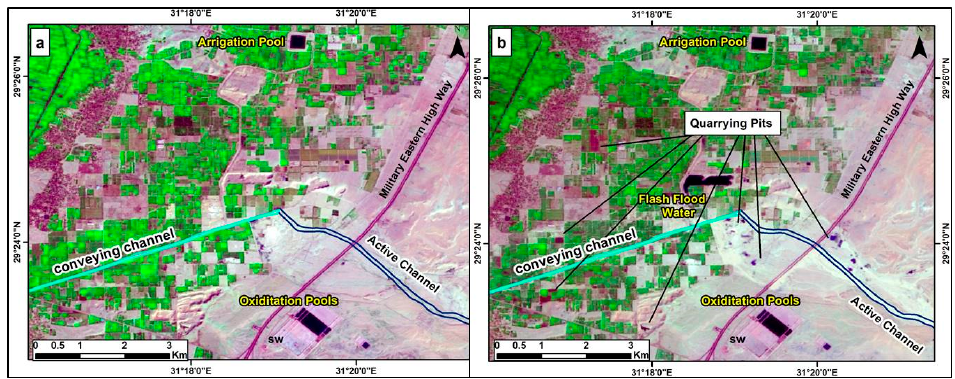
Figure 8. Multi-temporal Landsat 8 image close-up on the outlet of Wadi Atfeh catchment before ( a ) and after ( b ) the flash-flood event of 13 March 2020 showing the water accumulation in quarrying pits.